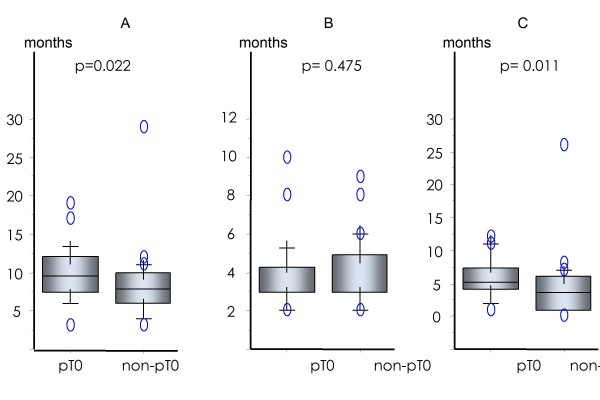
Duration of ADT: total (A), before (B), and after (C) PSA reached < 0.2 ng/ml or its nadir.